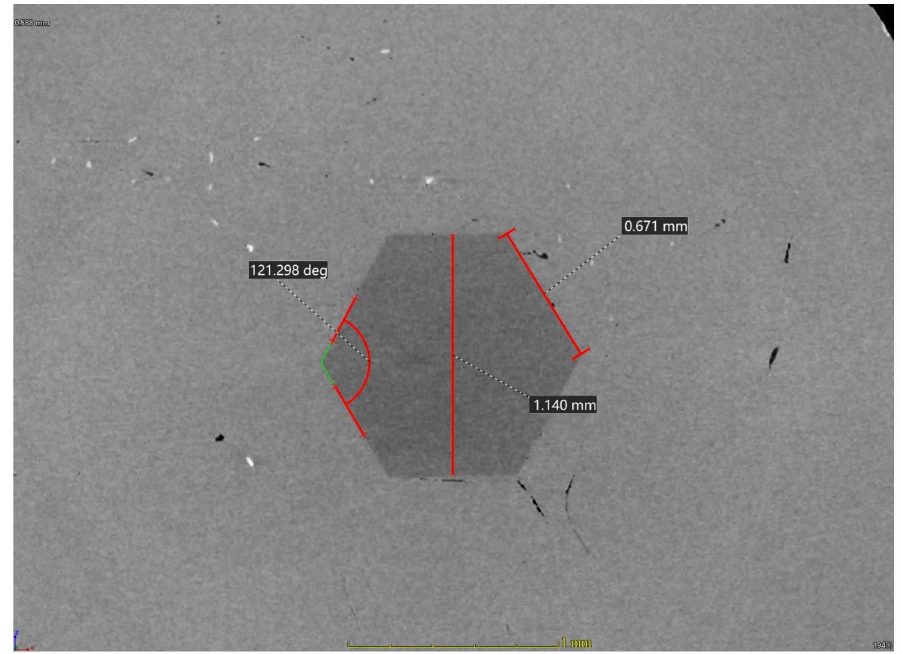
Figure 24. Measurement of the hexagonal core shows an internal angle of 121.298 degrees, a side length of 0.671 mm, and a distance between two parallel sides of 1.140 mm.